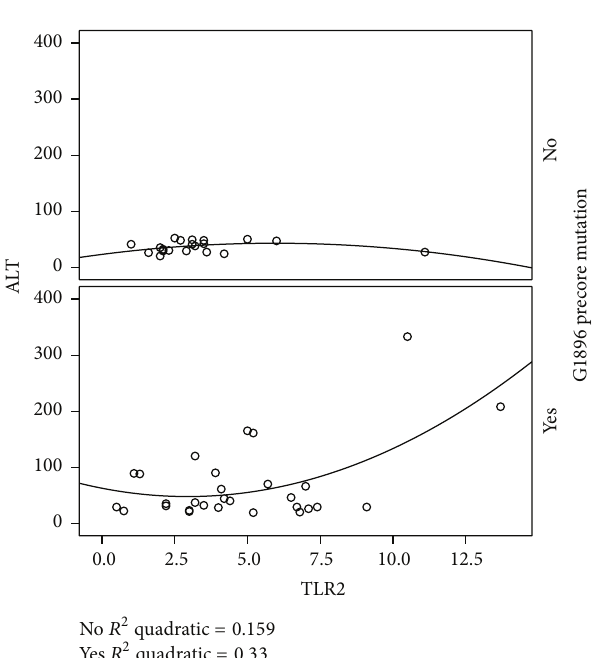
Figure 1: Estimating regression quadratic equation indicates that ALT sharply rises with increasing